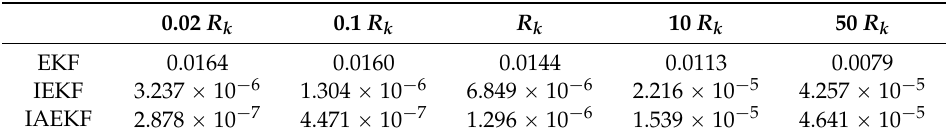
Table 4. RMSE (N) of KF-based force estimation techniques for F x “ 0.1sin p 2 π t q with different values of R k .